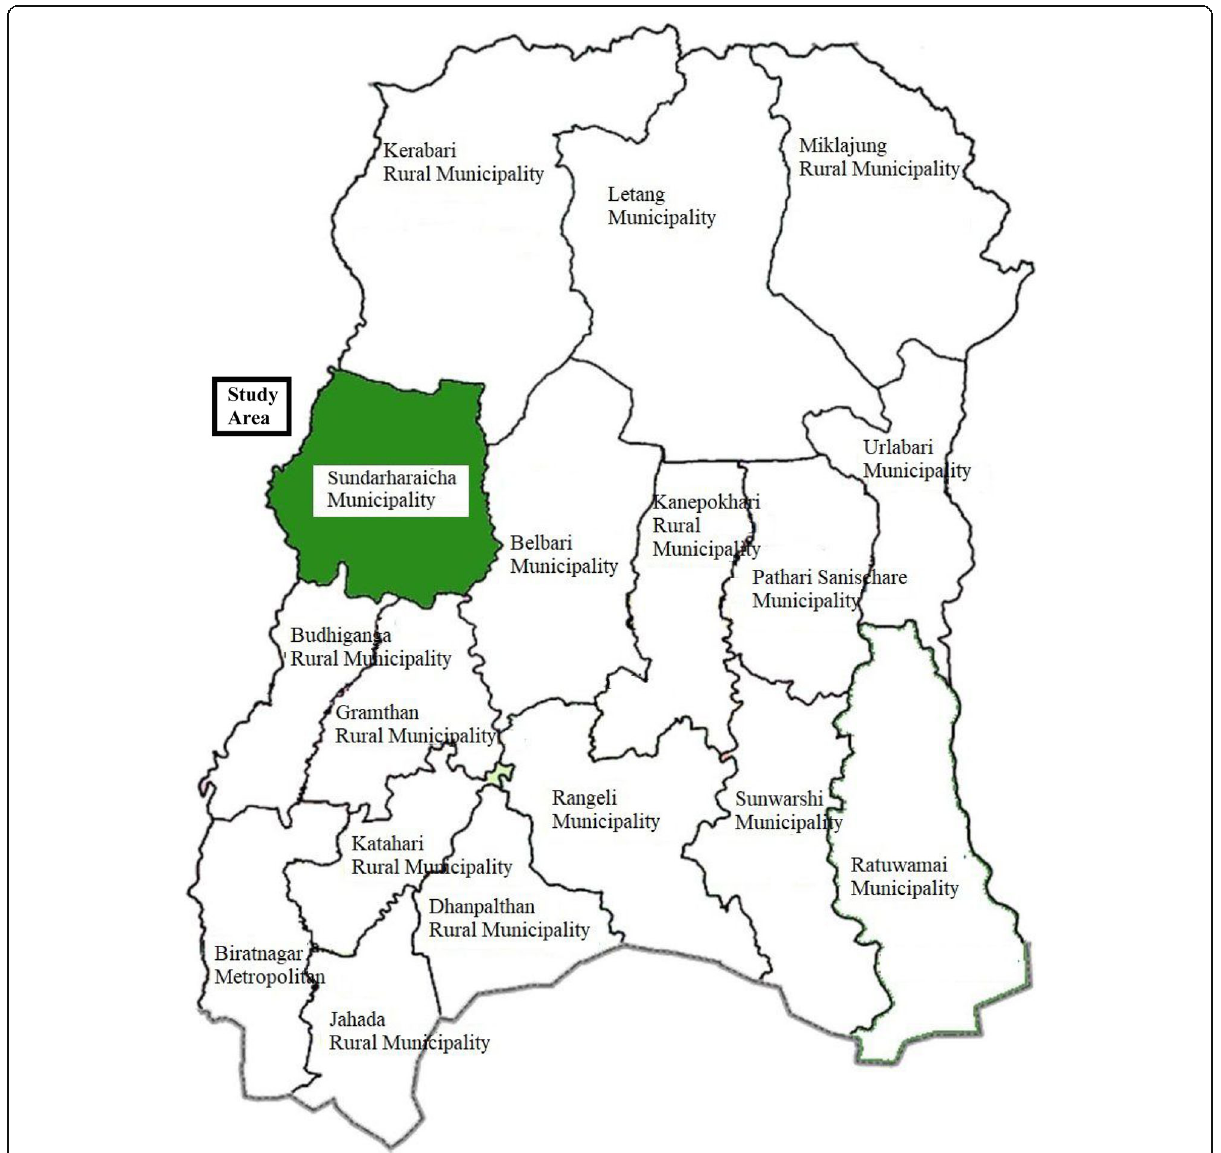
Fig. 2 Map of Morang district province 1, Nepal, showing study area (green